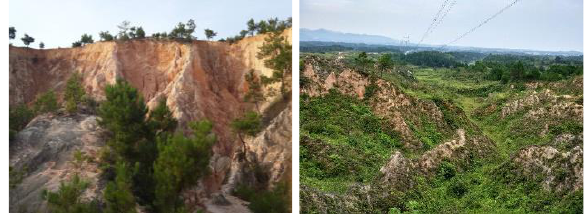
Figure 1. Typical Benggang in southern